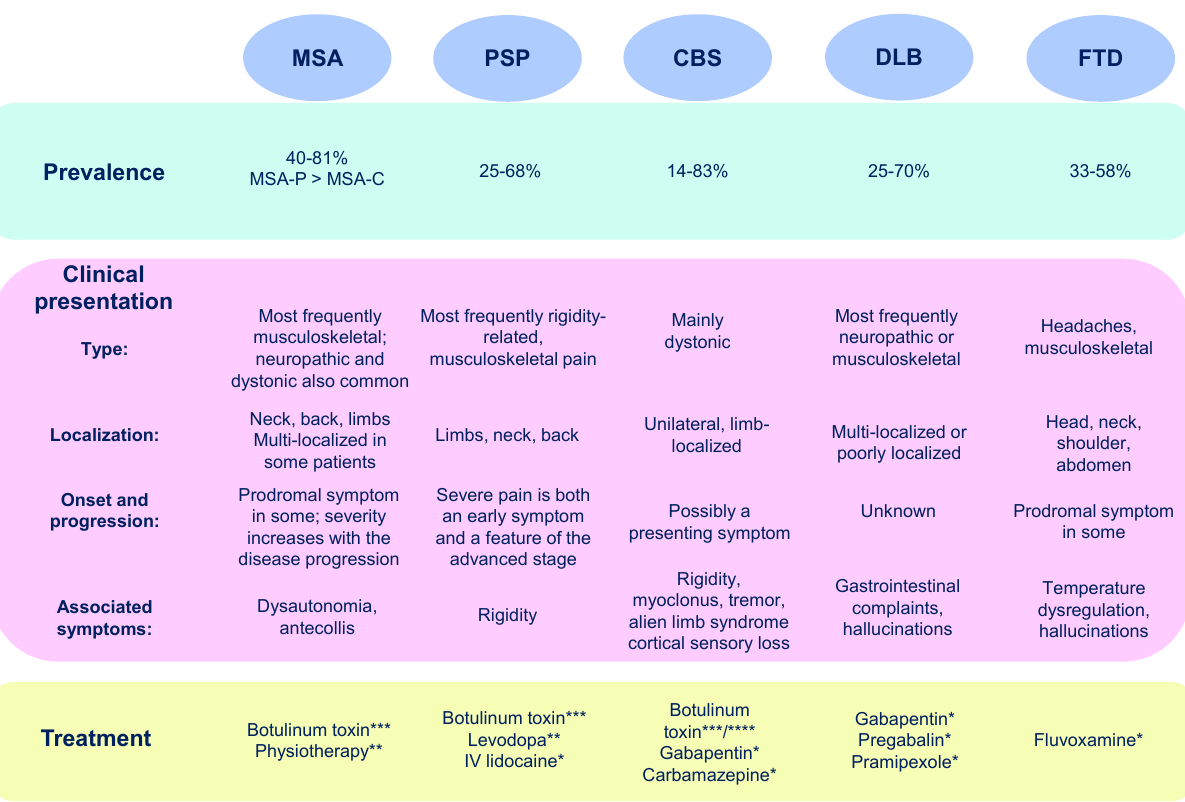
Fig. 1. Summary of evidence regarding prevalence, clinical presentation, and treatment (that have demonstrated efficacy) of pain in multiple system atrophy (MSA), progressive supranuclear palsy (PSP), cortico-basal syndrome (CBS), dementia with Lewy bodies (LBD), and frontotem- poral dementia (FTD). * Case report. ** Cross-sectional study. *** Retrospective chart review. **** Prospective open-label